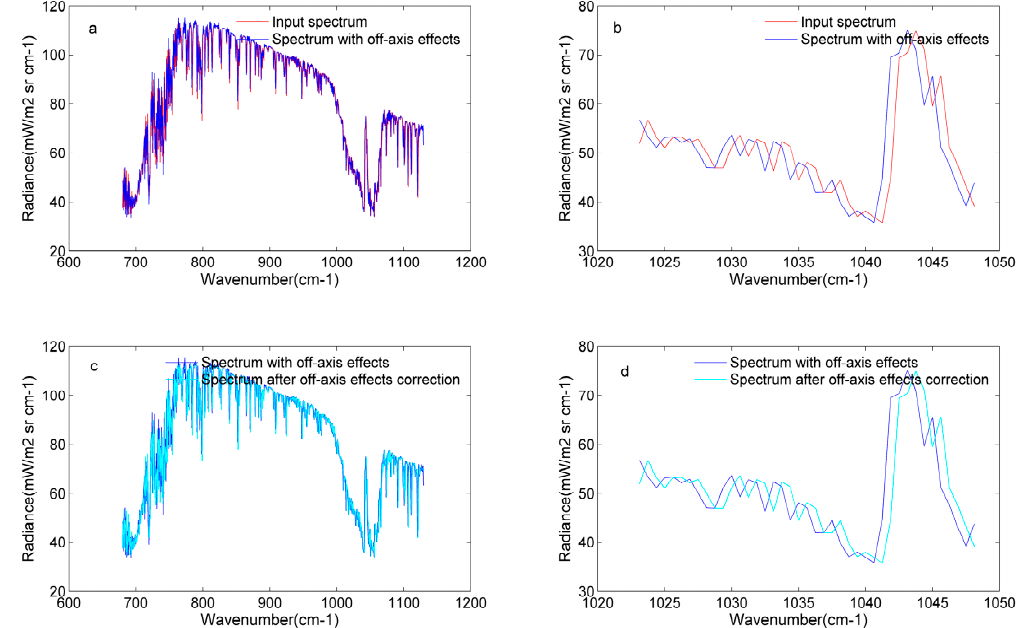
Figure 10. Analysis of off-axis effects for detector 81: ( a ) comparison between the input spectrum and the spectrum with off-axis effects from 680 to 1130 cm − 1 ; ( b ) comparison between the input spectrum and the spectrum with off-axis effects from 1023 to 1048 cm − 1 ; ( c ) comparison between the spectrum with off-axis effects and the spectrum after off-axis correction from 680 to 1130 cm − 1 ; ( d ) comparison between the spectrum with off-axis effects and the spectrum after off-axis correction from 1023 to 1048 cm − 1 .